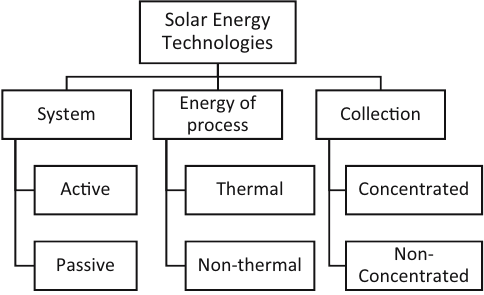
Figure 1: Classi fi cation of solar energy